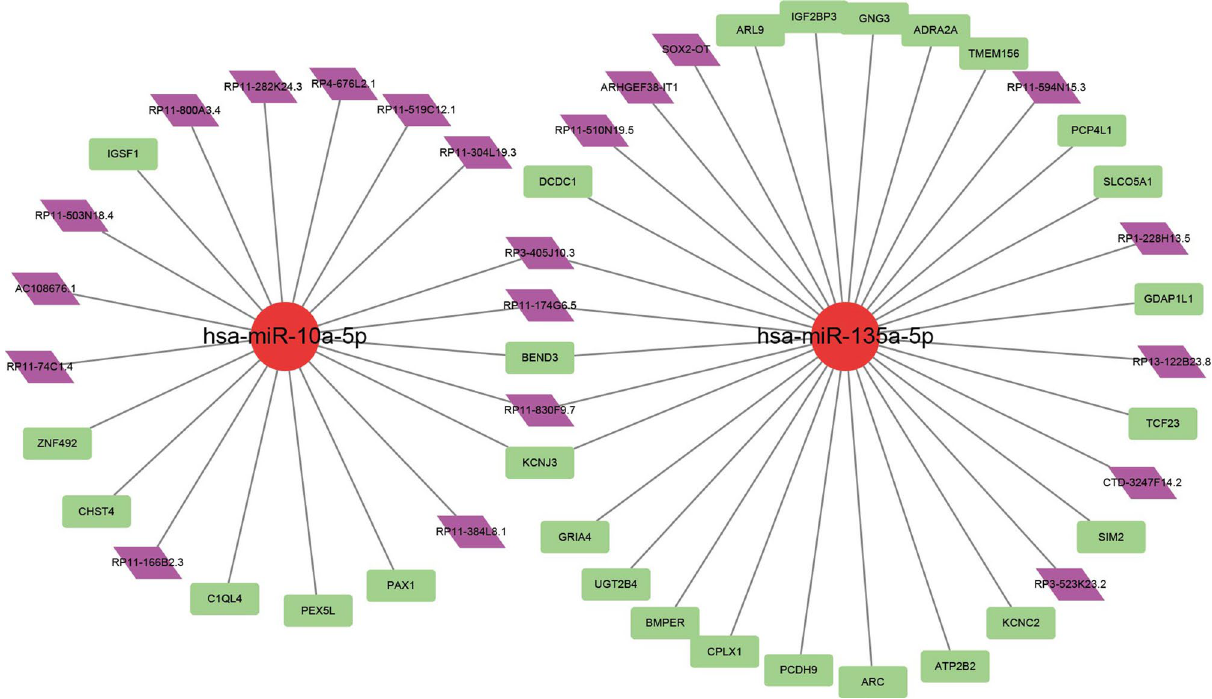
Figure 5. Construction of CD24-associated ceRNA